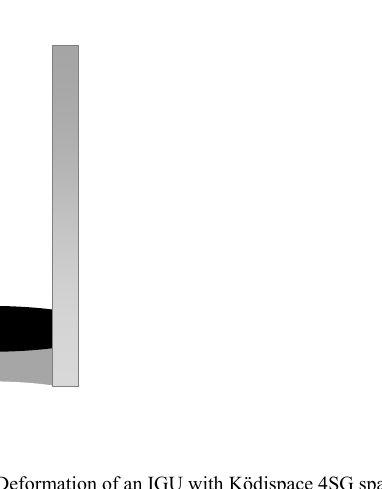
Fig. 18 Deformation of an IGU with conventional spacer due to thermal expansion, a) undeformed, b) deformed